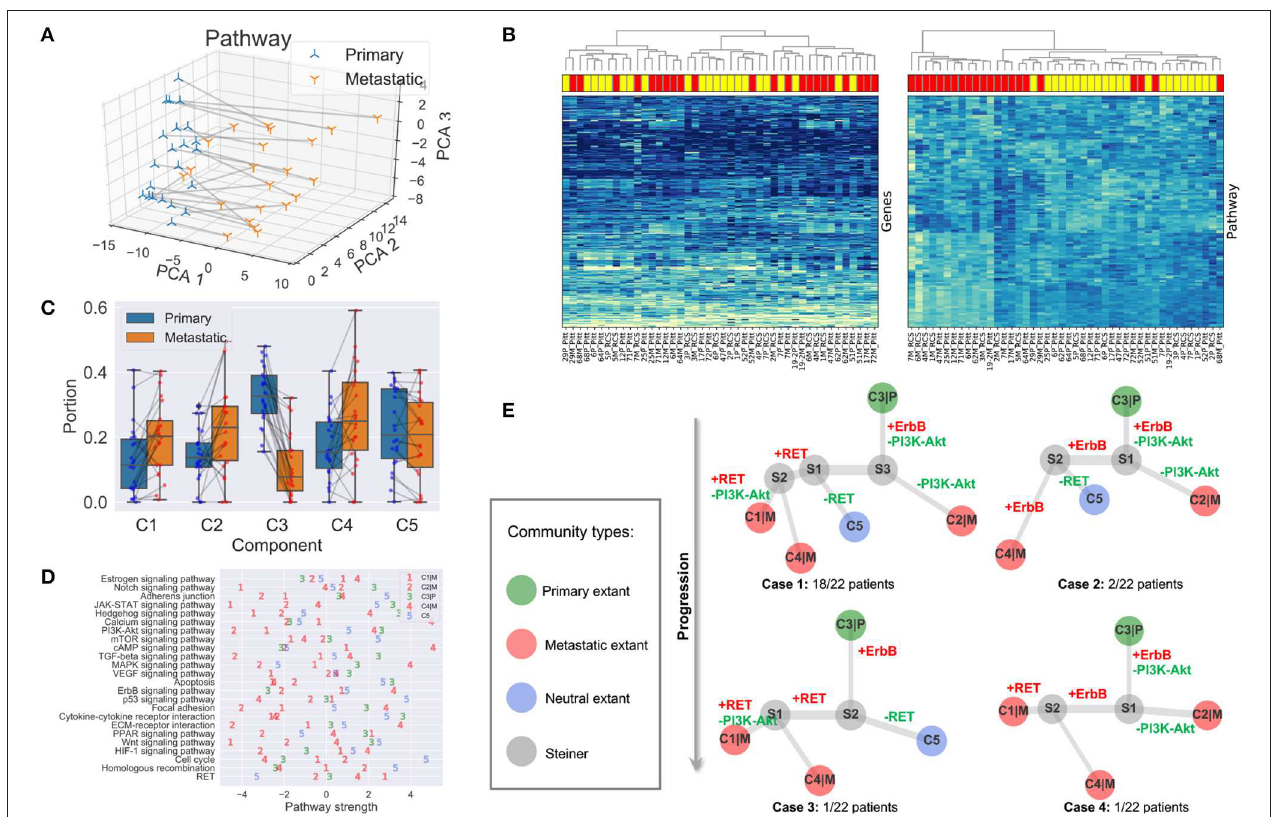
FIGURE 4 | Results and analysis. (A) First three gene module/pathway representation PCA dimensions of matched primary and metastatic samples. Matched samples are connected. (B) Hierarchical clustering of tumor samples based on raw gene expressions (left panel) and compressed gene module/pathway representation (right panel). Metastatic samples are shown in red rectangles and primary ones in yellow. (C) Portions and changes of the five communities in primary and metastatic sites. Each gray line connects the portions of a community in the primary site (blue node) and metastatic site (red node) from the same patient. (D) Pathway strengths across cell communities. (E) Phylogeny of cell subcommunities.